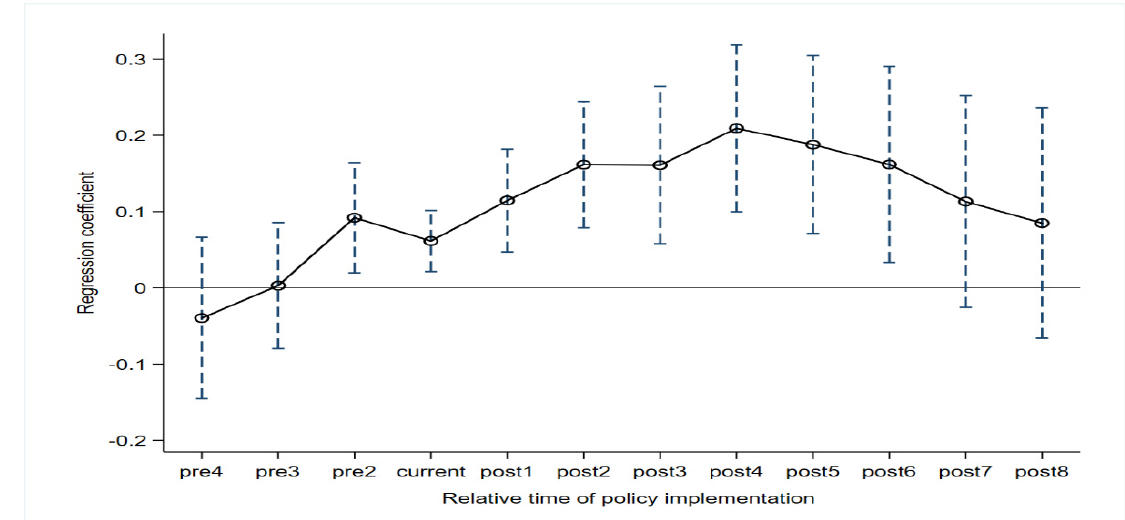
Figure 5. Dynamic evolution of the basic effect of the pilot policy.